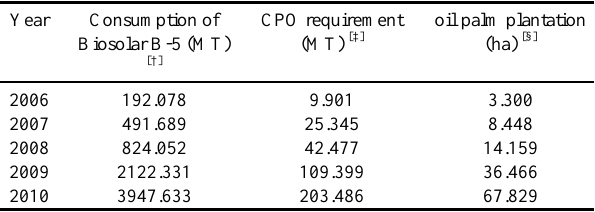
Table 14 . Domestic consumption of